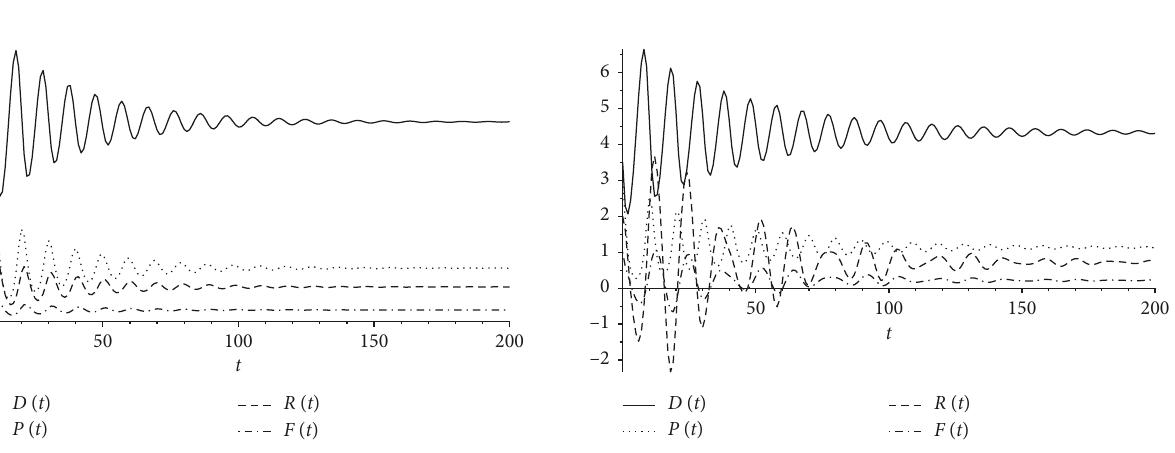
Figure 3: Numerical simulation diagram of system (2) when � 0 . 45 , τ � 0. τ 1 2